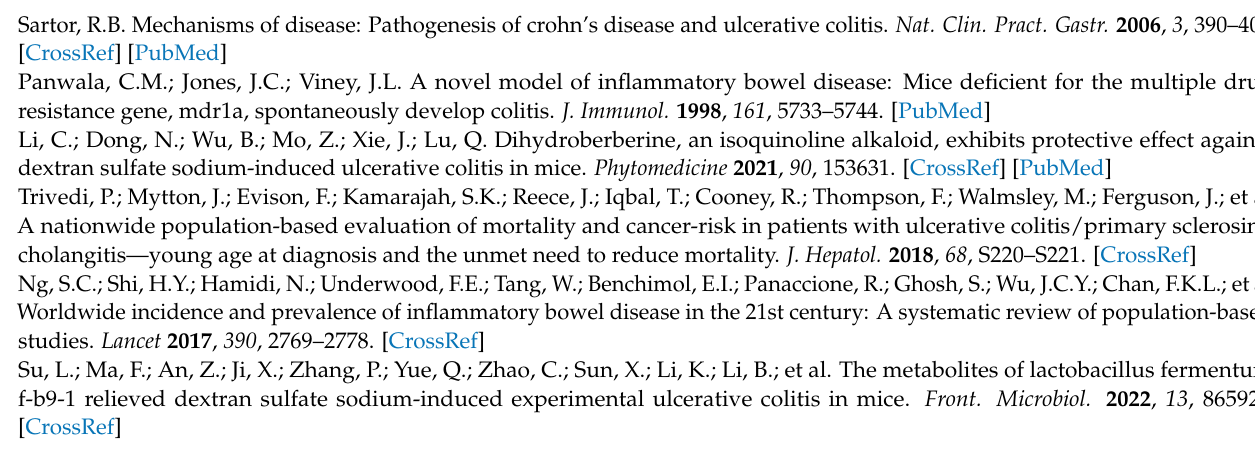
Table S3: 45 differential metabolites,Figure S1: metabolic pathways in the control group compared with the model group, Figure S2: metabolic pathways in the Pae-L group compared with the model group, Figure S3: metabolic pathways in the SASP group compared with the model